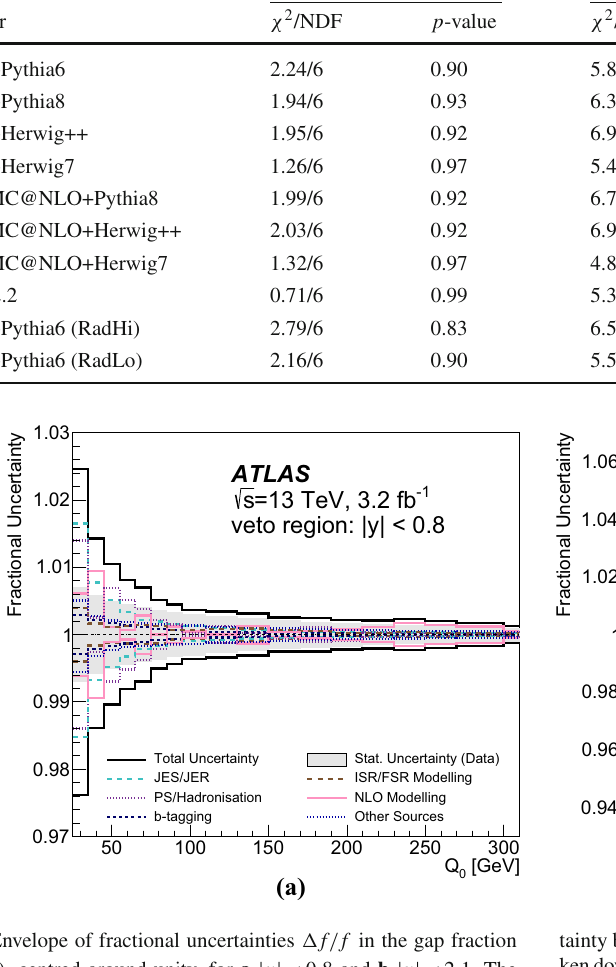
tainties.“Other”sourcesofsystematicuncertaintyrefertoleptonandjet selection efficiencies, background (including pile-up jets) estimations, and the